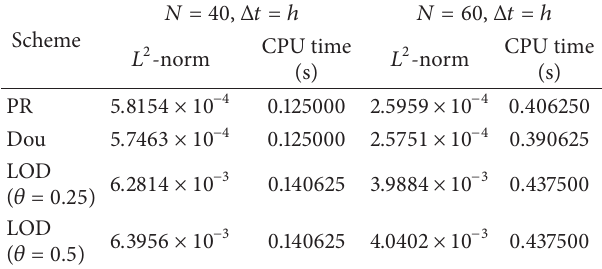
Table 1: The 𝐿 2 -norm and CPU time for the second-order schemes.